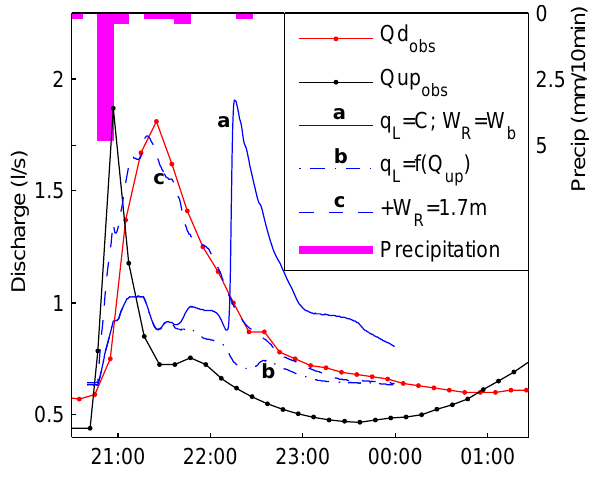
Fig. 4. Observed and simulated first discharge peak on 22 June 2008. The subscripts d and up refer to downstream and